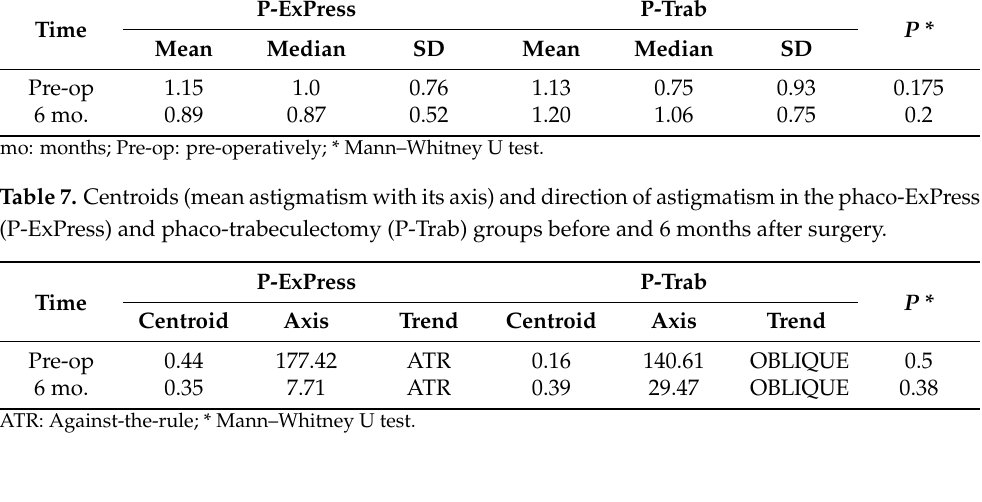
Table 6. Autorefractometry data: mean magnitude of positive cylinder form in the phaco-ExPress (P-ExPress) and phaco-trabeculectomy (P-Trab) groups before and 6 months after surgery. Time